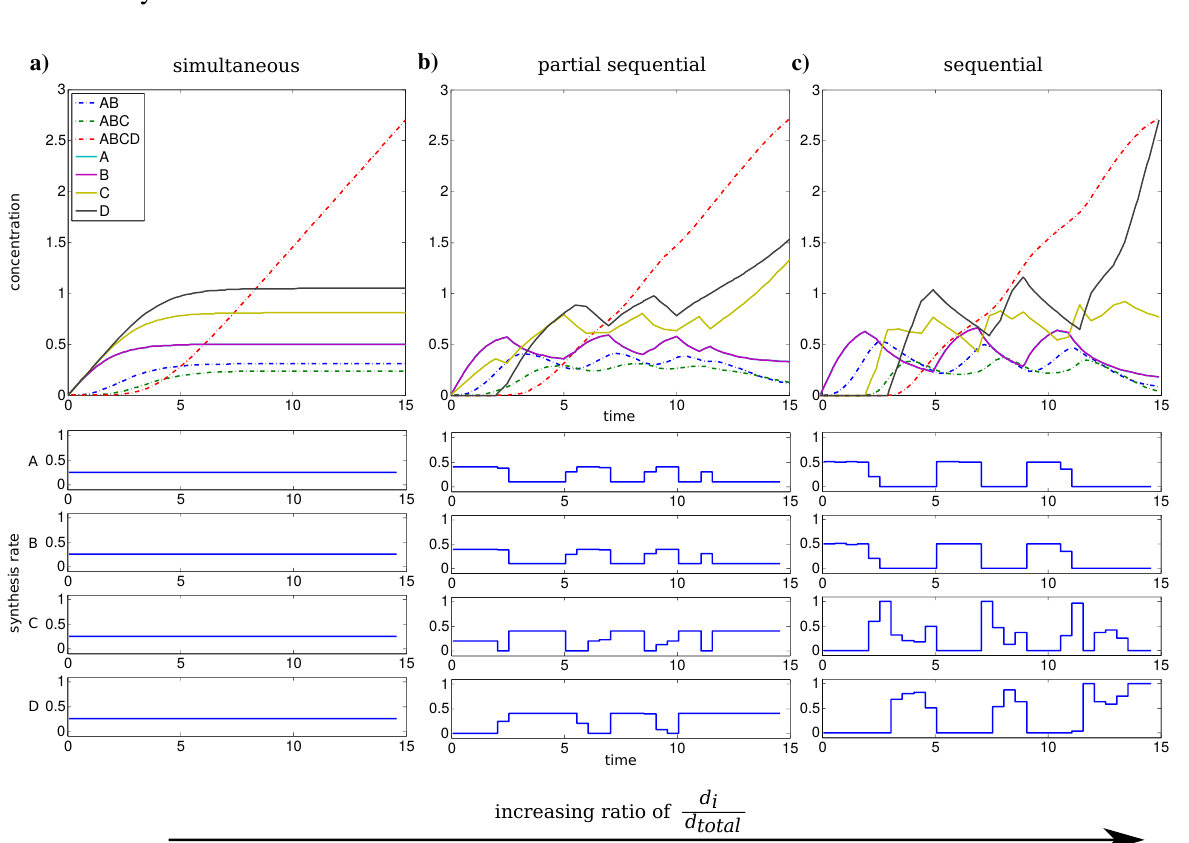
Figure 2. Time course of protein concentrations and synthesis rates for the individual synthesis rates d 0.25 ( a ), 0.4 ( b ) and 1 ( c ). Subunit concentrations in solid lines and i (sub)complexes in dashed